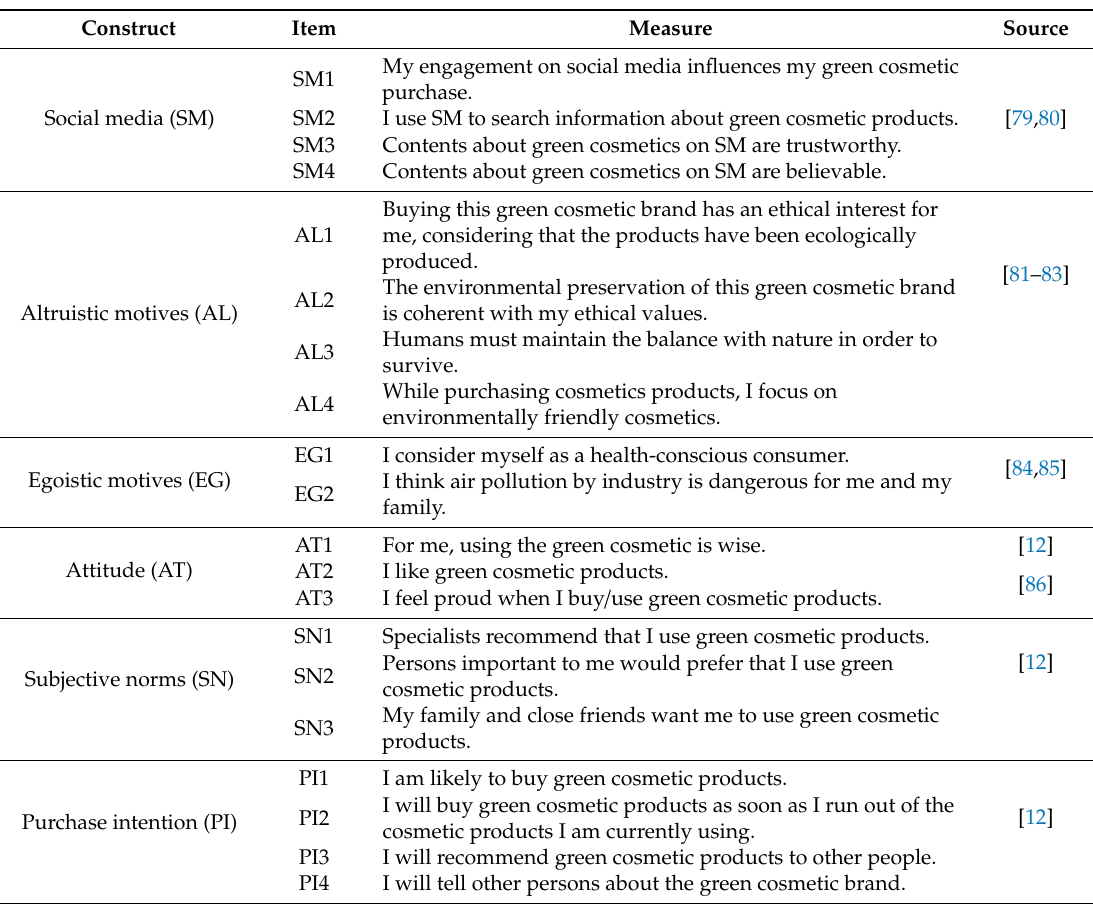
Table 2. Measurement of the reflective